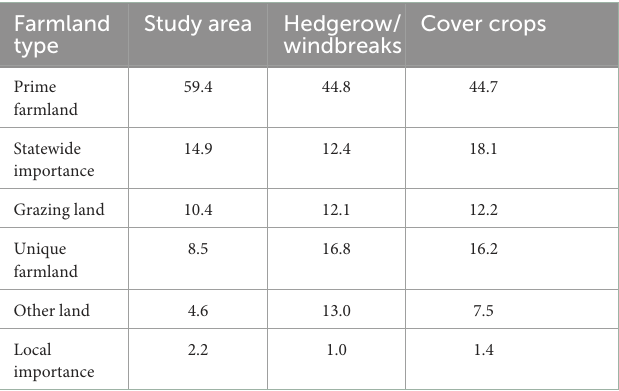
TABLE 3 Percent of total study area and percent of mapped hedgerow/windbreaks and cover crops found in each of the NRCS important farmland